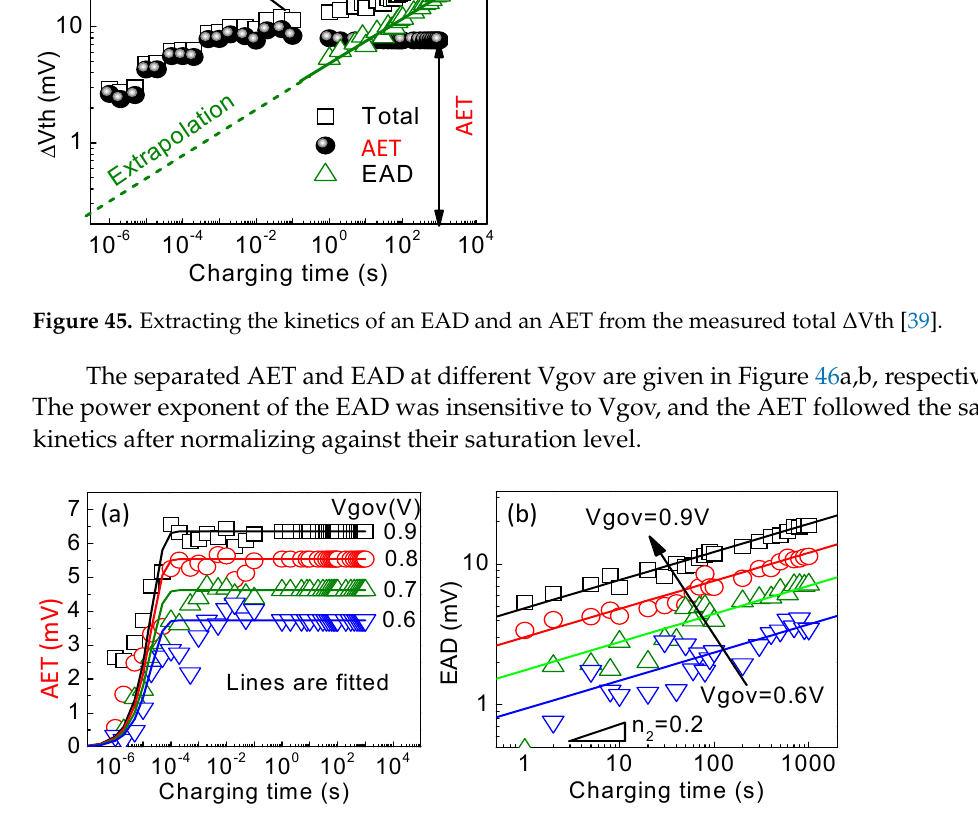
Figure 46. ( a ) AET kinetics under different filling Vgov; ( b ) EAD kinetics under different Vgov [39].